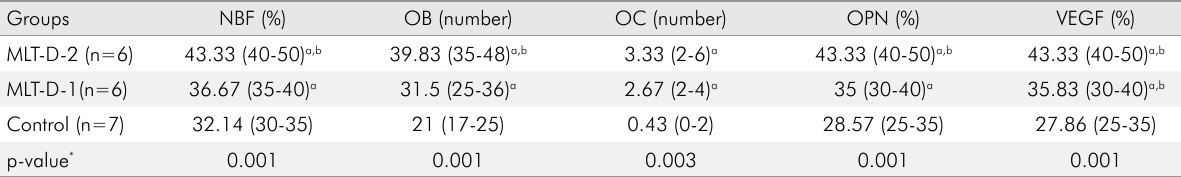
Table. Histomorphometric and immunohistochemical analysis of the groups.